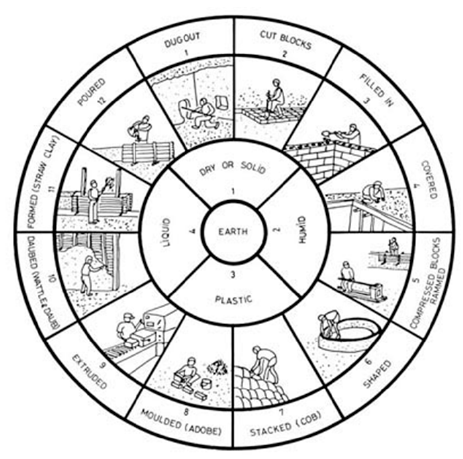
Figure 2. Main earth techniques classification, according to water content [8]